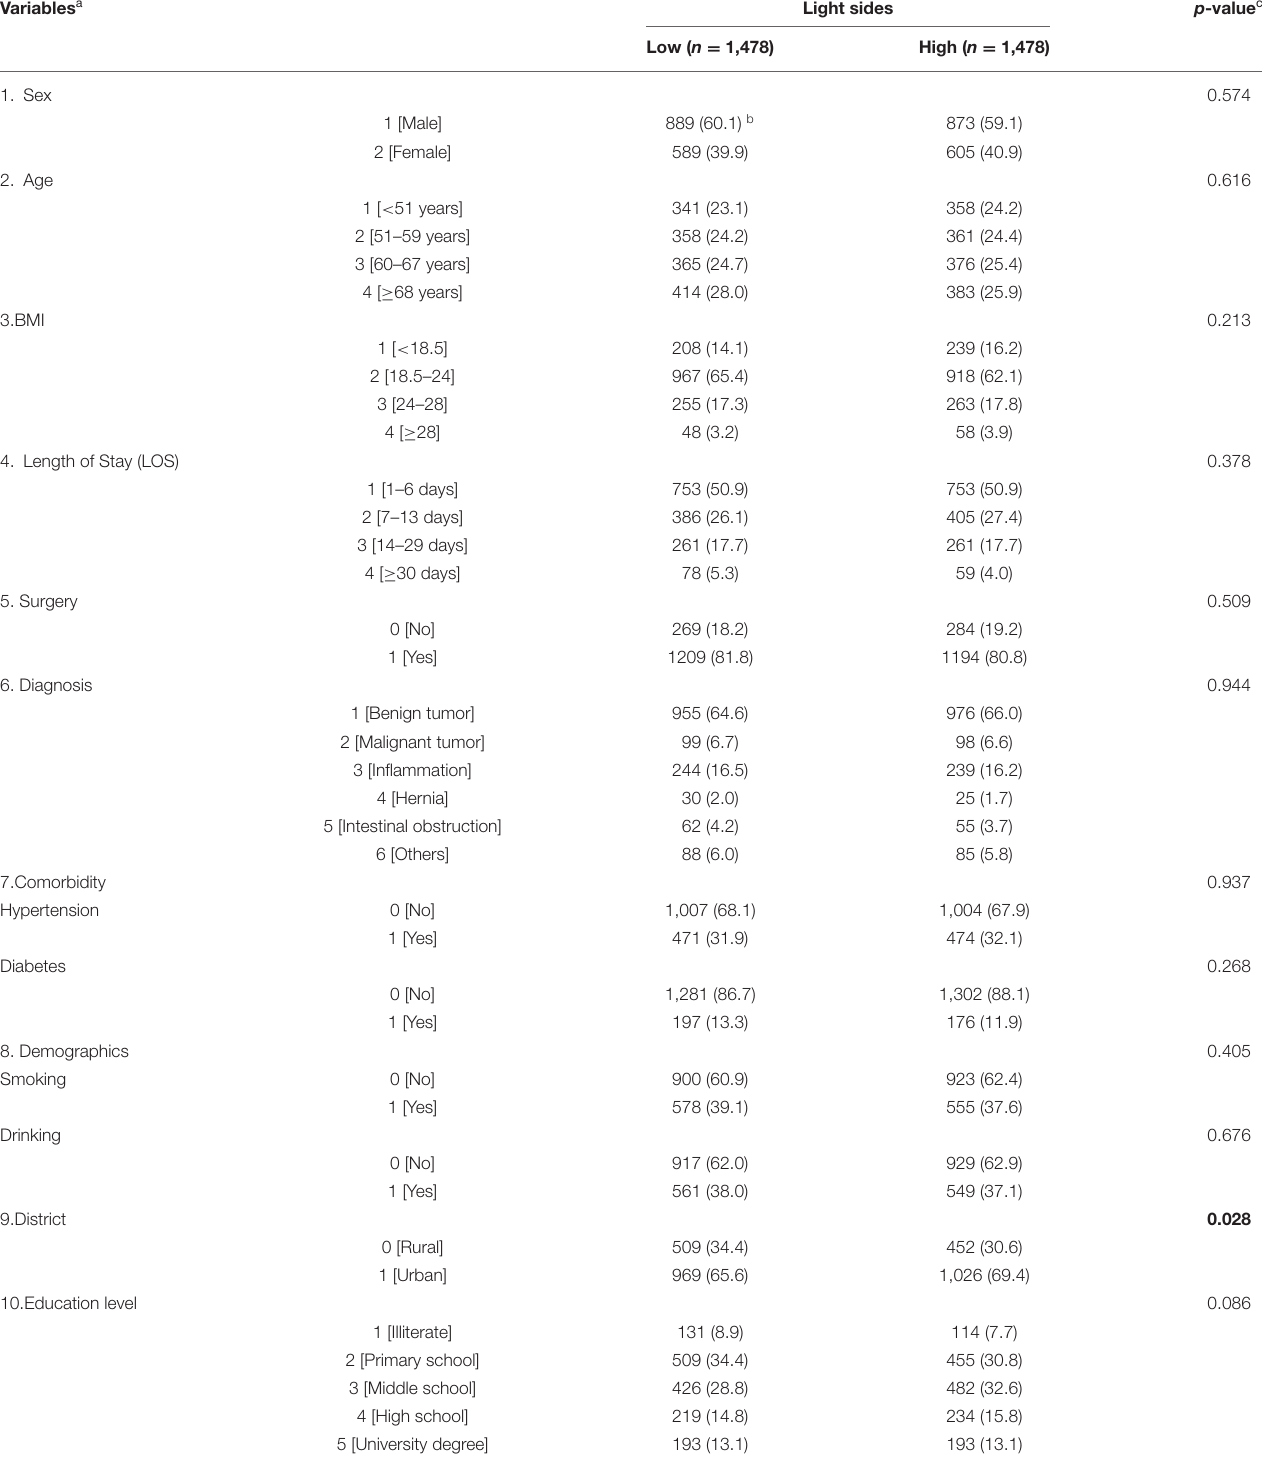
TABLE 1 | Basic characteristics of patients on low light and high light sides of the hospital